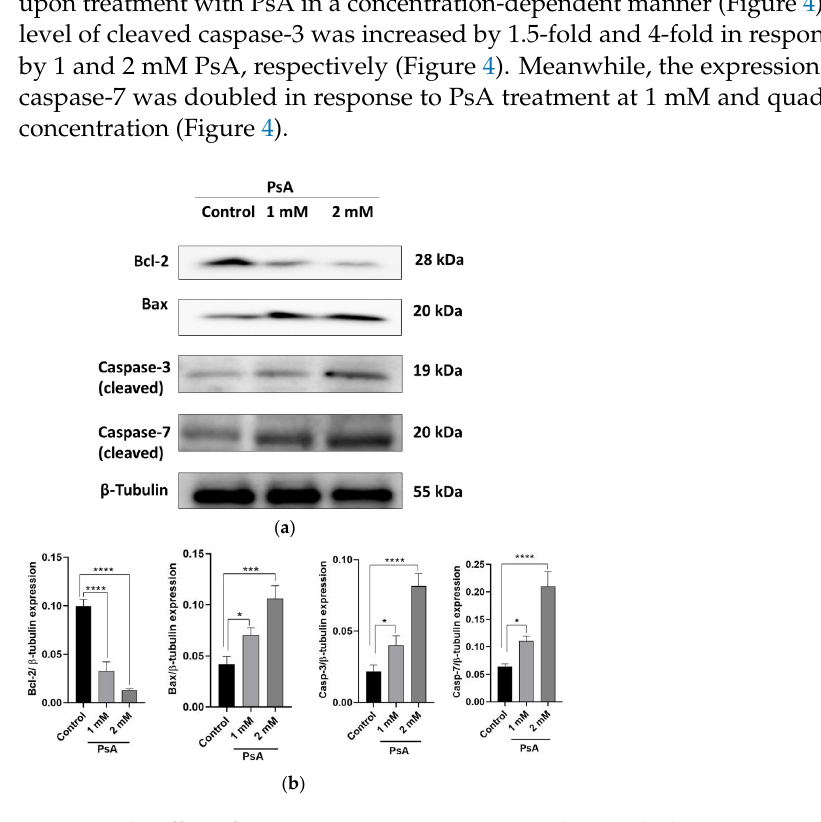
Figure 4. The effect of PsA treatment on apoptotic markers in the human RWPE-1 non-tumorigenic prostate epithelial cells. ( a ) Immunoblots of Bcl-2, Bax, caspase-3 and caspase-7, and β-tubulin from the cell lysate in control, and PsA-treated cells at 1 and 2 mM. ( b ) Densitometric analysis of apoptotic markers protein bands relative to tubulin in each band for B-cell lymphoma 2 (Bcl-2), Bcl-2 associated X-protein (Bax), caspase-3, and caspase-7. * indicates a statistical significance at p < 0.05, *** indicates a statistical significance at p < 0.001, and **** indicates a statistical significance at p < 0.0001 at specified concentrations vs. control.